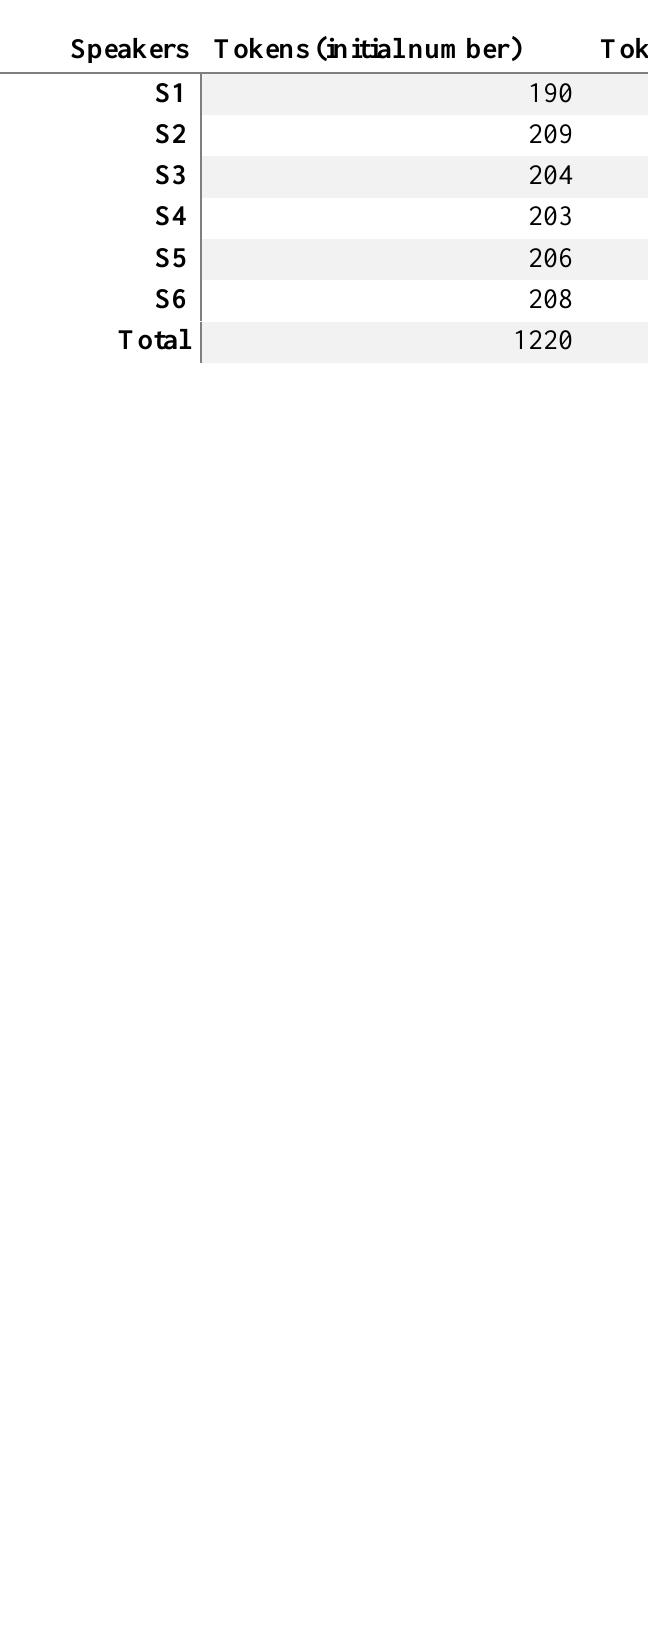
Table 4. Number of tokens per